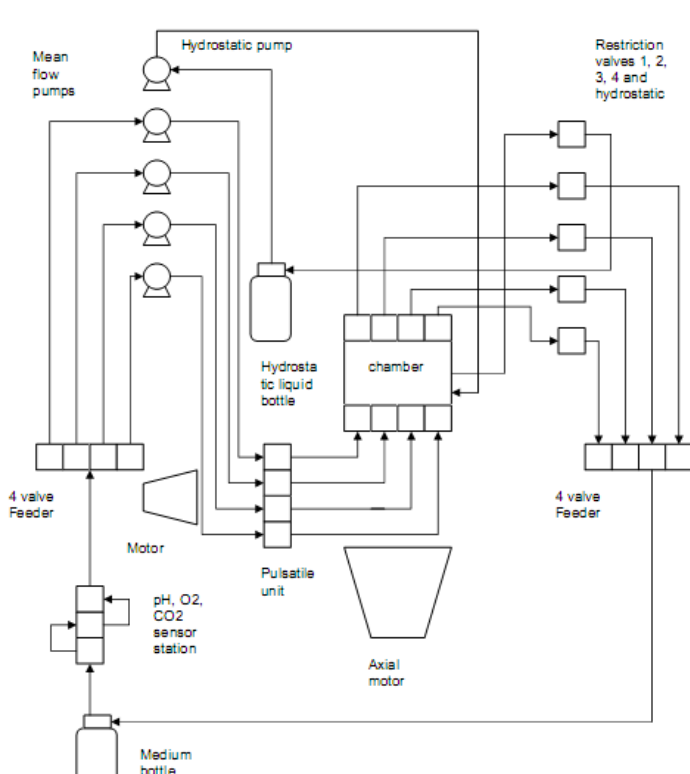
Figure 2. Flow loop of the